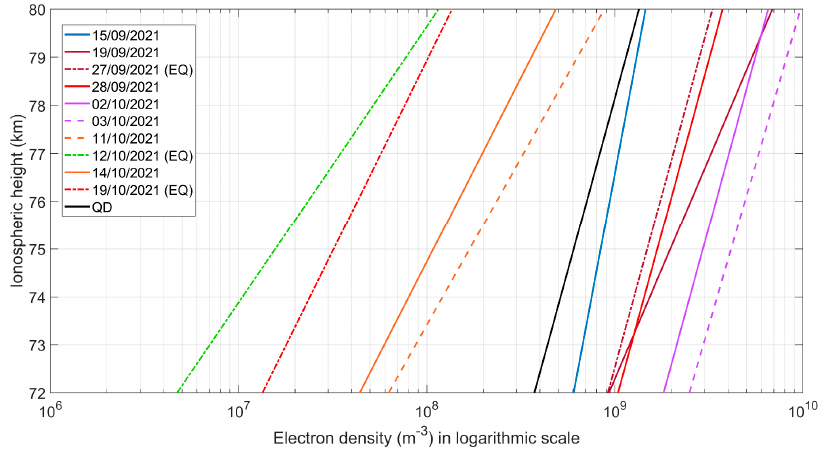
Figure 13. Same as Figure 12 for SST1 of ISR–GER path.